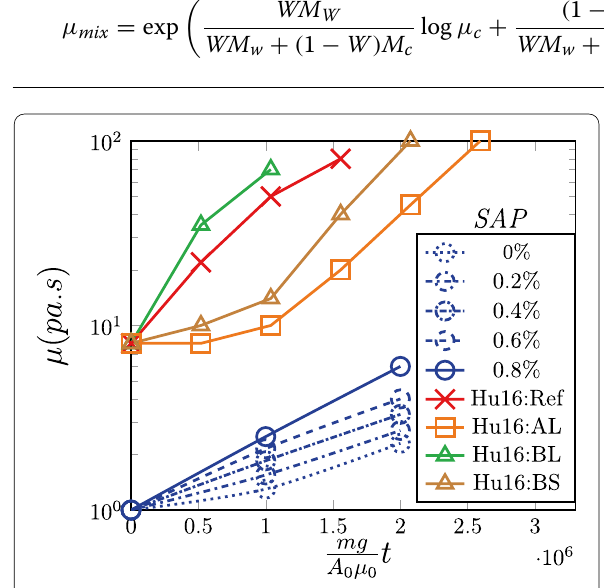
Fig. 5 Obtained viscosities compared with reported data with W ≈ 10%